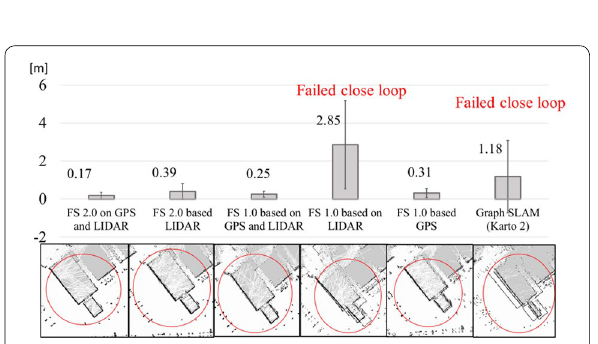
Fig. 9 Result of local consistency in Area 1